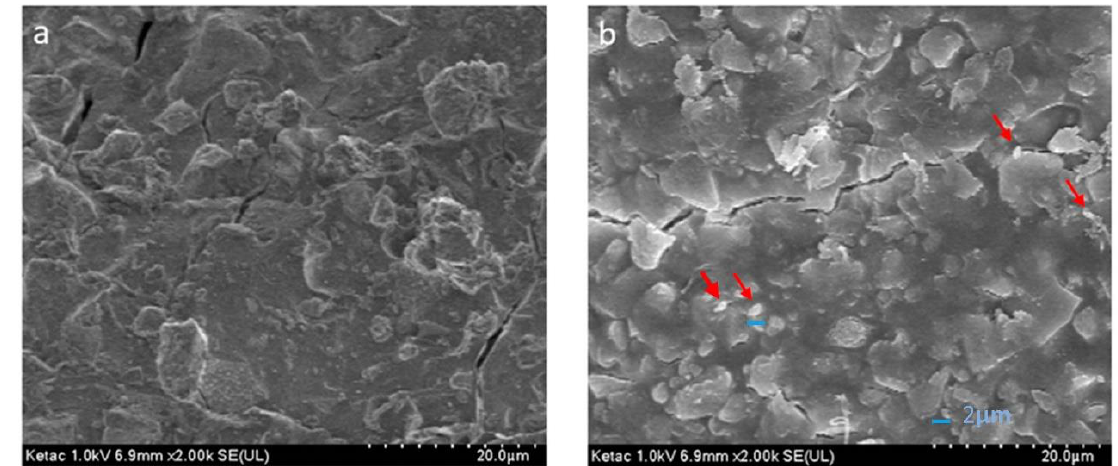
Figure 7. ( a ) Ketac Cem group, ( b ) Ketac Cem group with halloysite nanotubes.